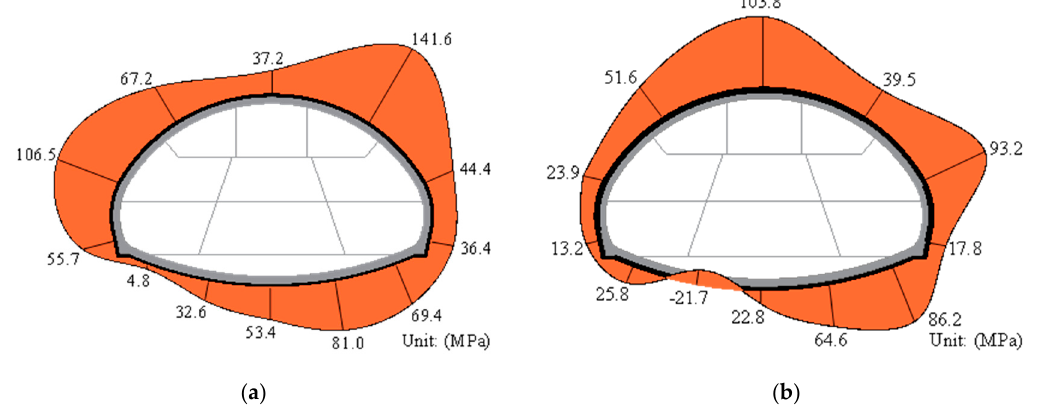
Figure 18. Final distribution of the internal forces in the four bar lattice girders: ( a ) inner side; ( b ) outer side.